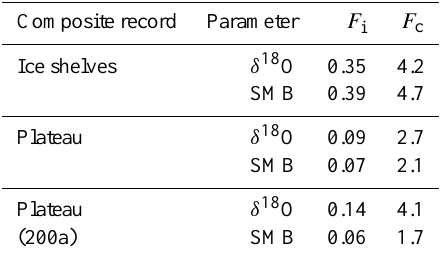
Table 2. Signal-to noise variance ratio of δ 18 O and SMB in the individual records ( F i ) ( N ) (see Eq. 1) compared to the composite records ( F c ). F c is determined by multiplying F i with the number of individual cores contained in the composite